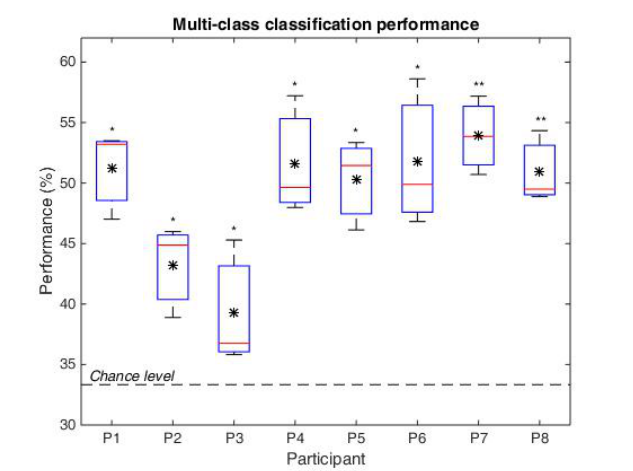
Figure 9. Multi-class classification performance (Uni, Nat, Frac) for each participant, considering the three folds. The box-plots consider the 25% and 75% percentiles, the the black asterisk represents the mean values and the red horizontal line is the median.